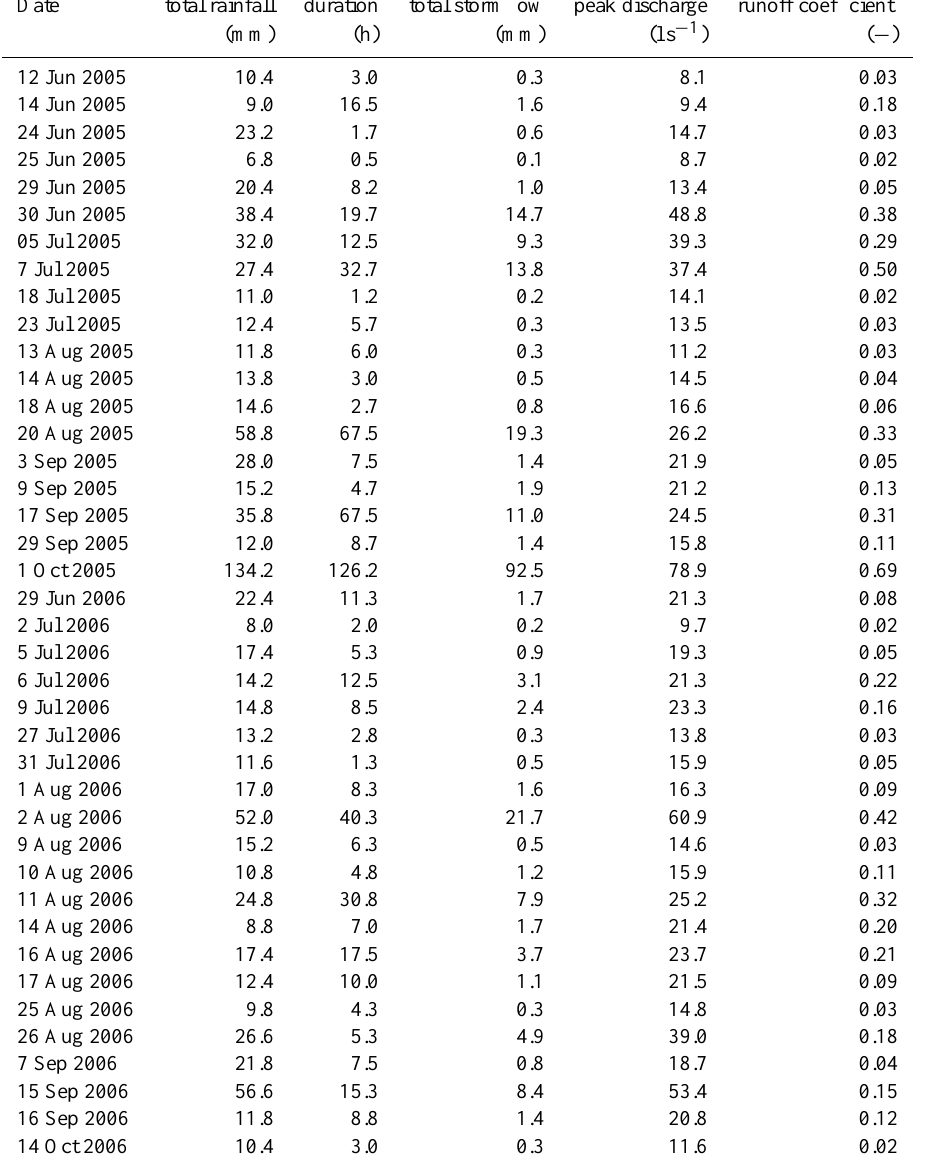
Table 2. Properties of selected rainfall-runoff events. The runoff coefficient had a mean of 0.15, a coefficient of variation of 1.05, and a skewness of